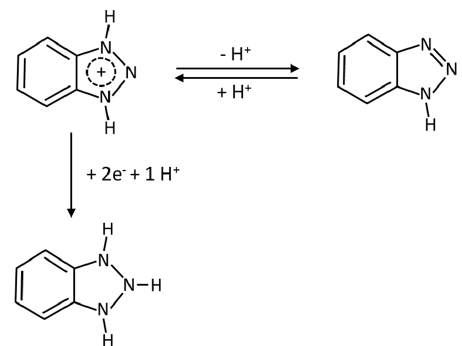
Figure 4. Tautomeric forms and electroreduction process of BZT in acidic media.